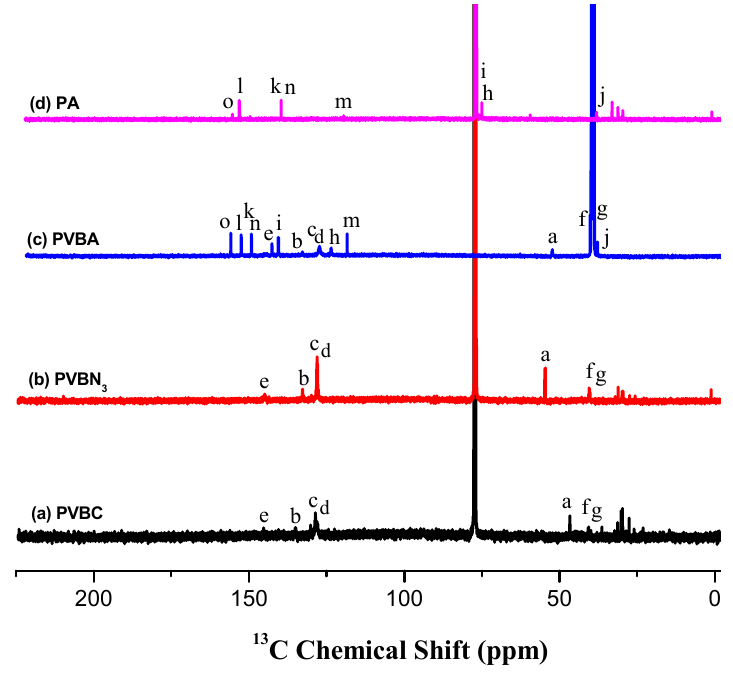
Figure 2. 13 C NMR spectra of ( a ) PVBC in CDCl d -DMSO; and ( d ) PA in CDCl 6